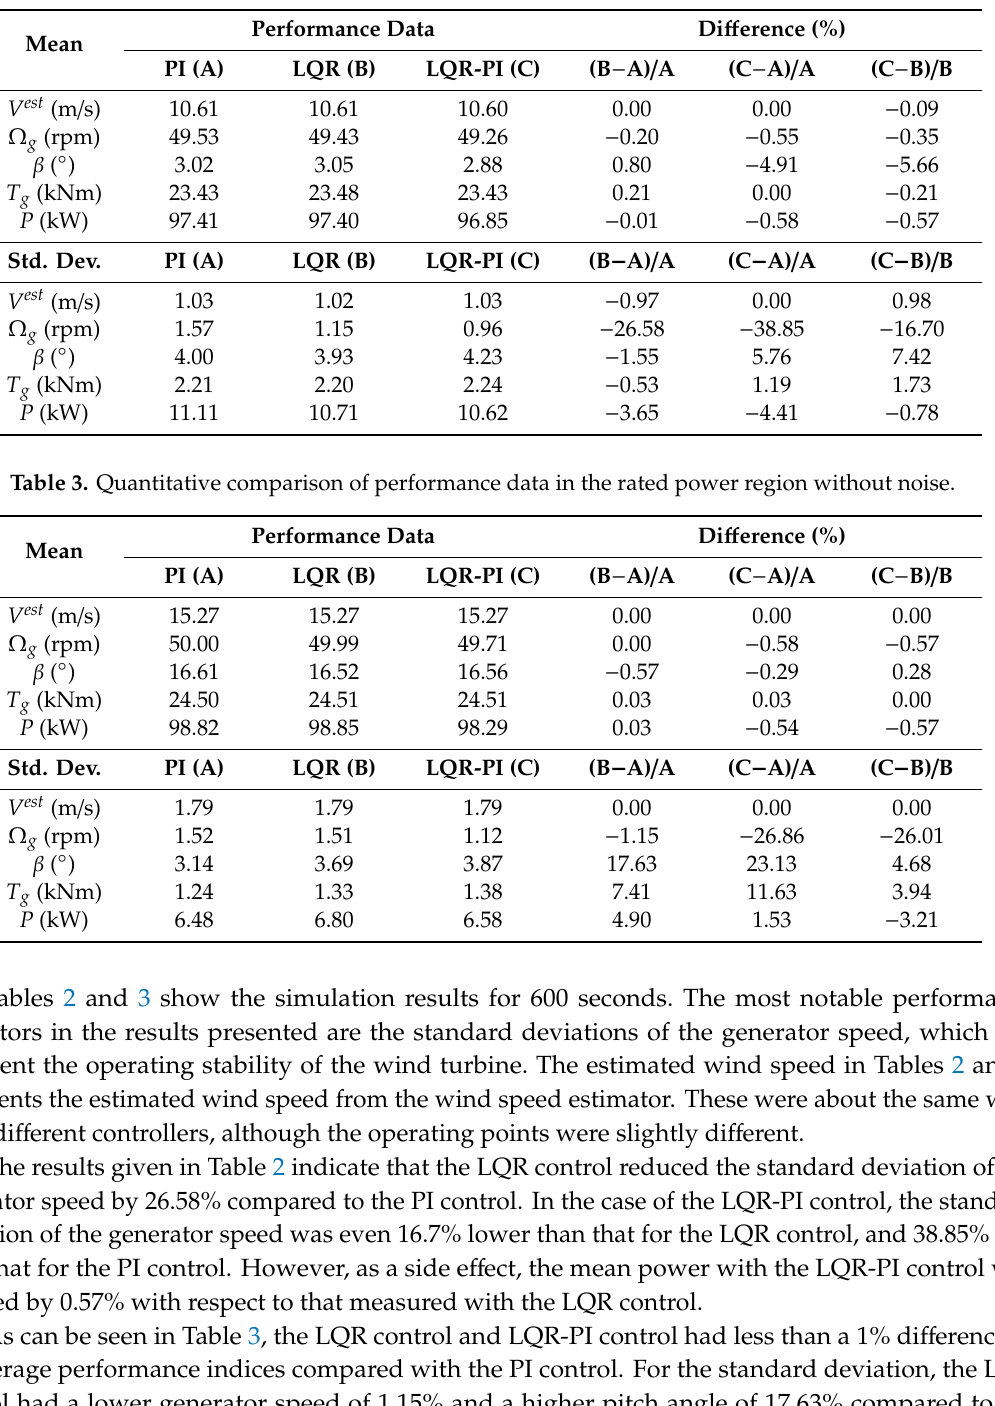
Table 2. Quantitative comparison of performance data in the transition region without noise.